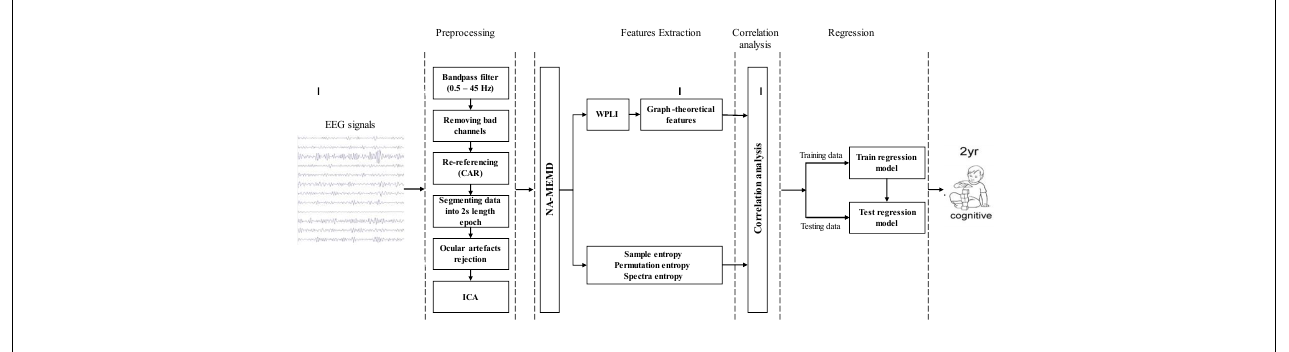
FIGURE 1 | Schematic outline of proposed analysis for predicting cognitive outcomes at 2 years of age.